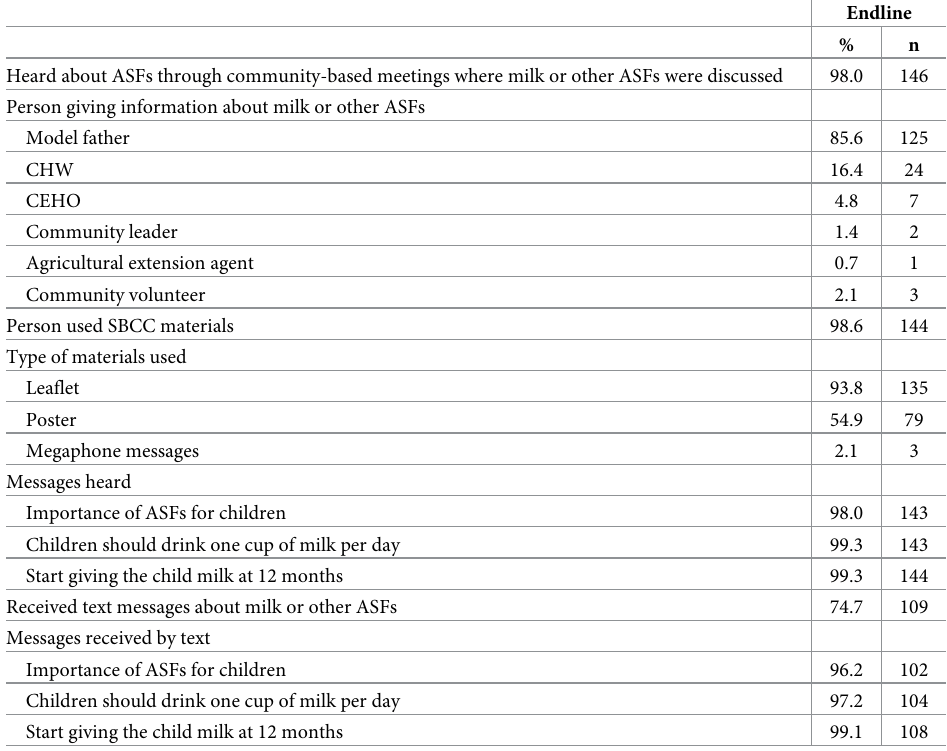
Table 5. Fathers’ exposure to the intervention (N =